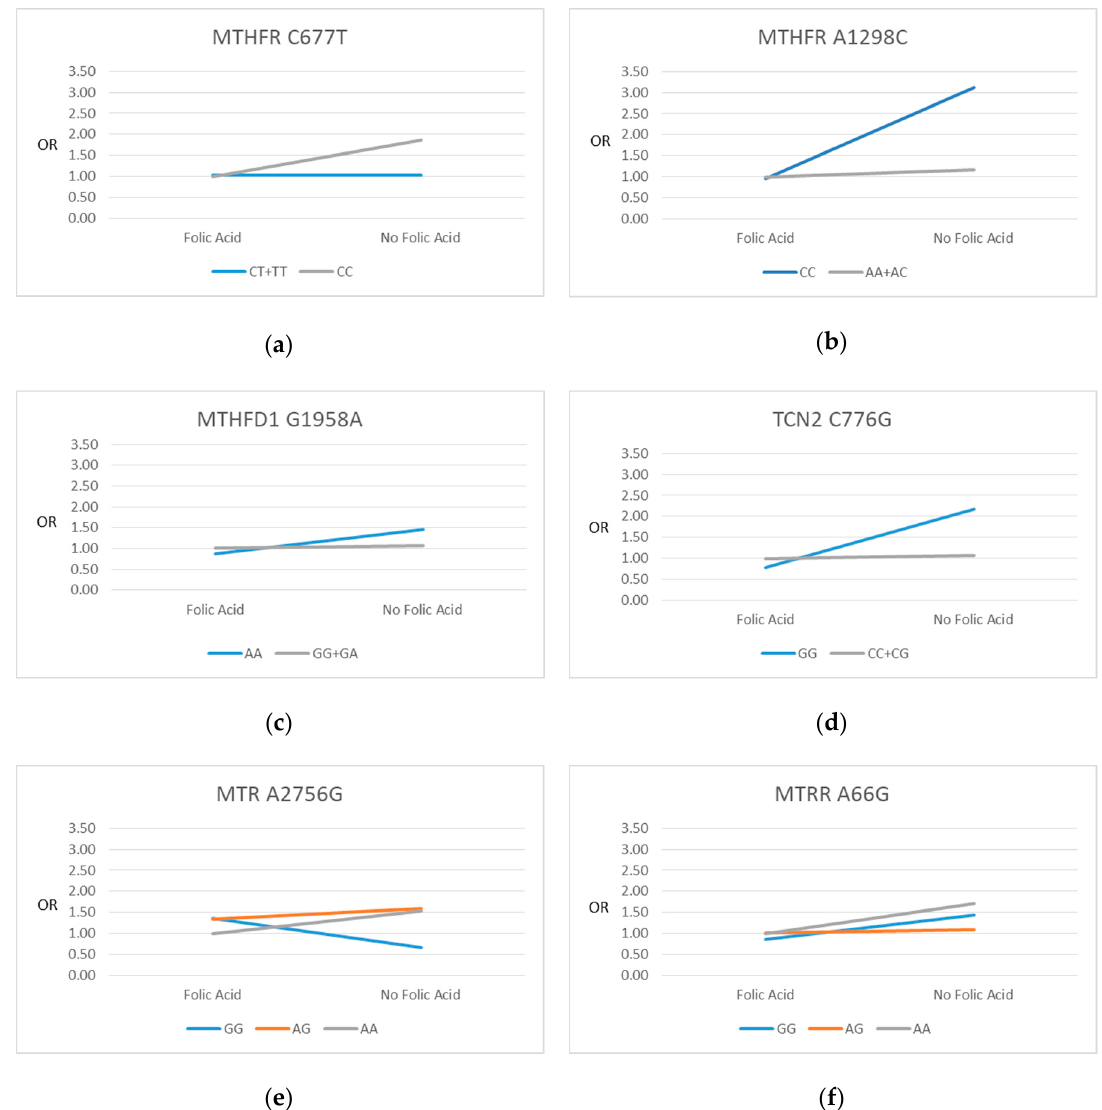
Figure 2. Plots of regression odds ratios (OR): SNP vs. SGA by maternal folic acid supplement use at 15 weeks’ gestation. ( a ) MTHFR C677T; ( b ) MTHFR C1298A; ( c ) MTHFD1 G1958A; ( d ) TCN2 C776G; ( e ) MTR A2756G; ( f ) MTRR A66G. Folic Acid: reference category (defined as those who took folic acid